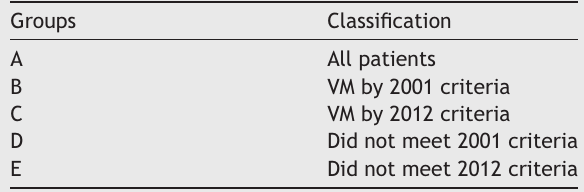
Classification of patients using the 2001 and 2012 criteria for vestibular migraine (VM)